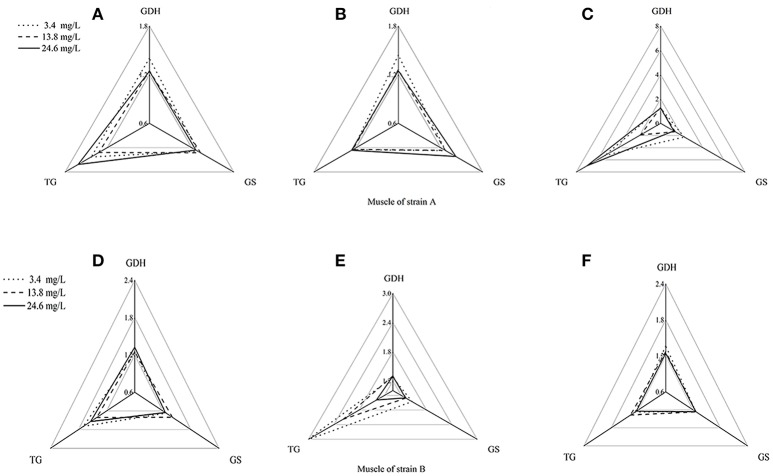
Star plots for biomarkers response in muscles of strains A and B exposed to different ammonia-N concentrations. The relative area of triangles (clockwise direction) indicates the affected degree of ammonia-N to GDHase, TGase and GSase, respectively. (A) Star plots for biomarkers response in muscle of strain A under ammonia-N pollution stress for the first day. (B) Star plots for biomarkers response in muscle of strain A under ammonia-N pollution stress for the fifth day. (C) Star plots for biomarkers response in muscle of strain A under ammonia-N pollution stress for the tenth day. (D) Star plots for biomarkers response in muscle of strain B under ammonia-N pollution stress for the first day. (E) Star plots for biomarkers response in muscle of strain B under ammonia-N pollution stress for the fifth day. (F) Star plots for biomarkers response in muscle of strain B under ammonia-N pollution stress for the tenth days. Keys: GDHase, Glutamate dehydrogenase; TGase, Transglutaminase; GSase, Glutamine synthetase.